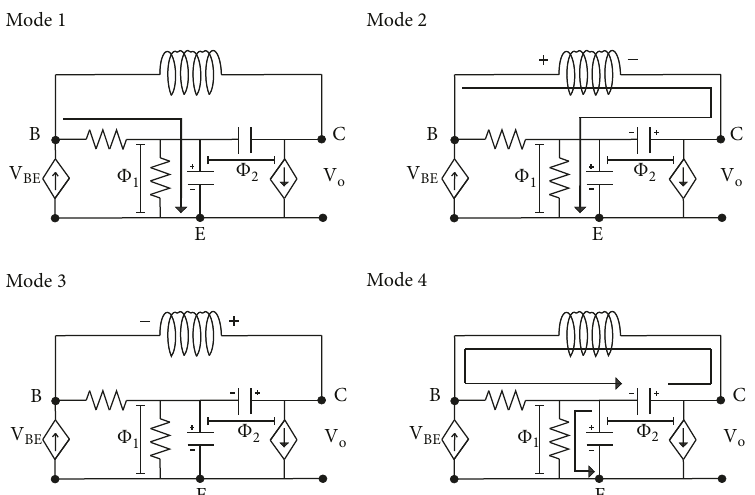
Figure 3: Operation modes for the proposed circuit of Figure 1(b) as a function of the transient current paths and potentials actuating on transition junction